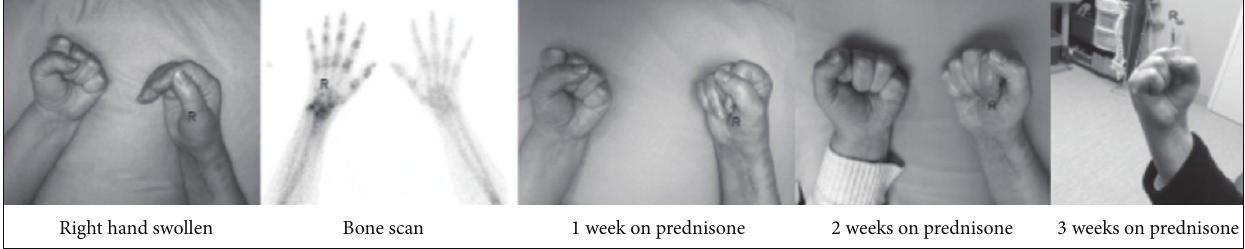
Right hand swollen Figure 3: Case 3 : a 50-year-old woman fell, sustaining an incomplete cervical spinal cord injury, right wrist fracture, and pulmonary emboli. She had excellent motor recovery but one month after discharge she developed a painful swollen right hand. When she was seen at two months, the pain had peaked but it was painful with metacarpophalangeal joint compression and she had very little function in the right hand due to an inability to fist the